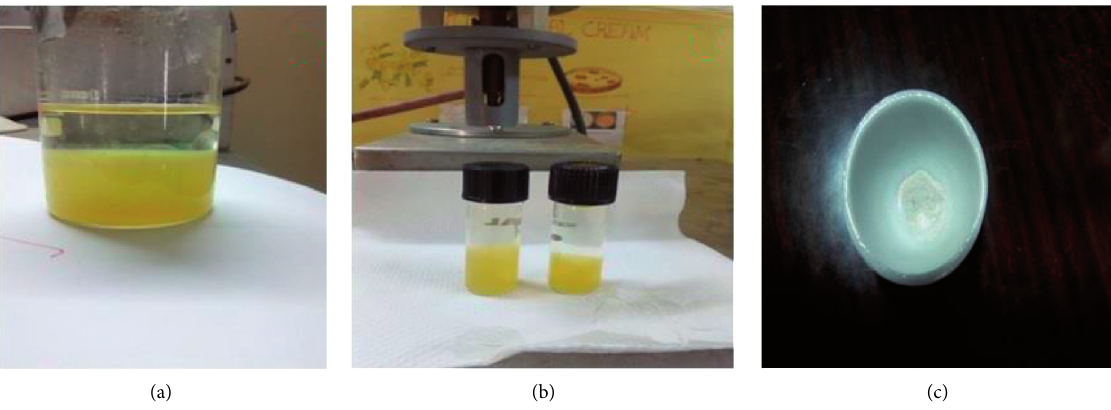
Figure 2: Mg (OH) 2 nanoparticle (a, b) and MgO nanopowder